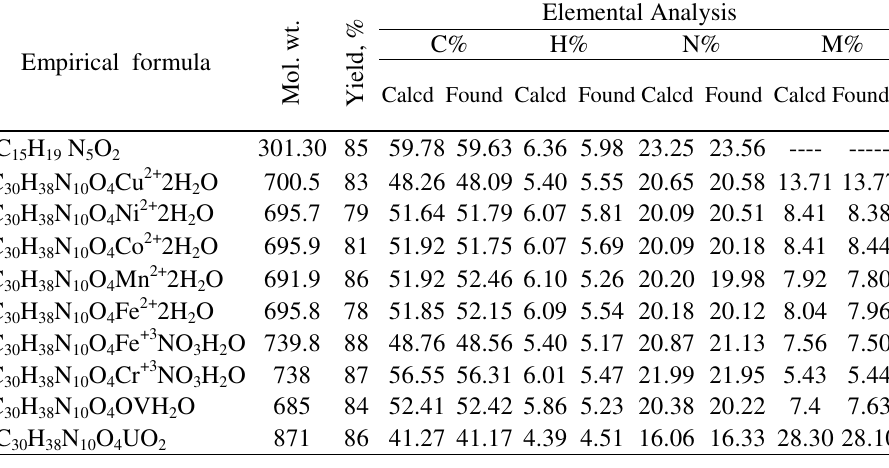
Table 1. Analysis of BUMP-SC ligand and its metal